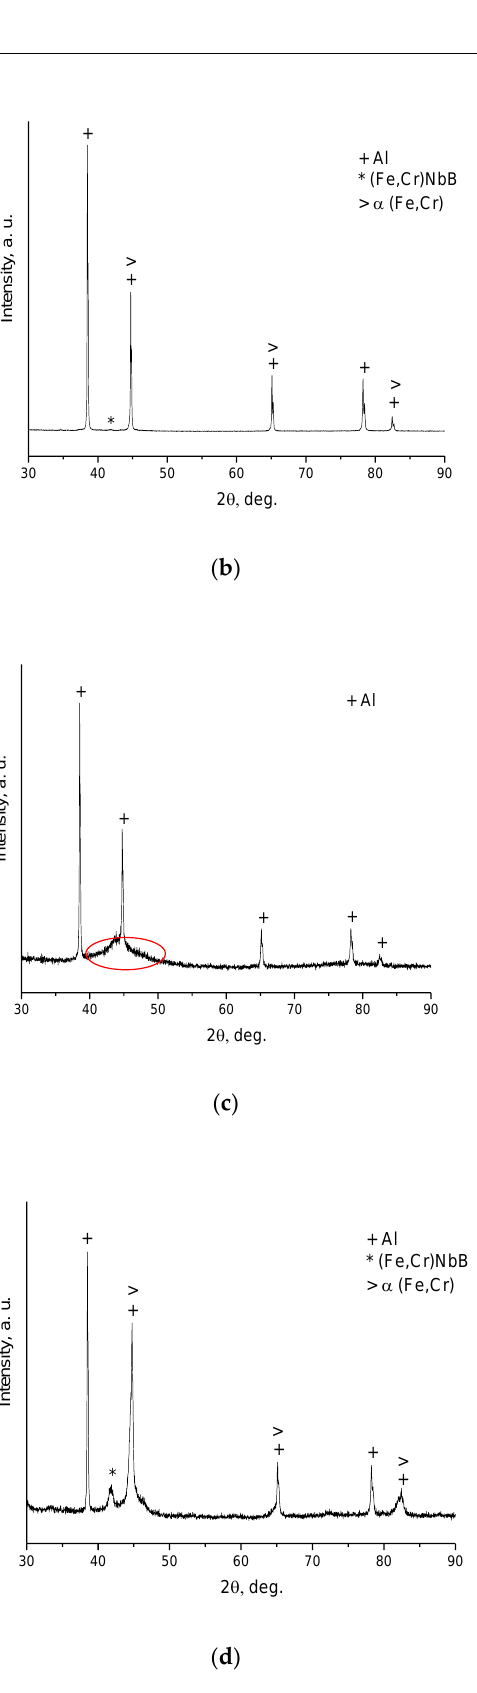
Figure 4. XRD patterns of the spark plasma sintered composites obtained from ( a ) Al (coarse)–glassy Fe 66 Cr 10 Nb 5 B 19 ; ( b ) Al (coarse)–crystalline Fe 62 Cr 10 Nb 12 B 16 ; ( c ) Al (fine)–glassy Fe 66 Cr 10 Nb 5 B 19 ; and ( d ) Al (fine)–crystalline Fe 62 Cr 10 Nb 12 B 16 mixtures. A red oval in ( a , c ) marks the range, in which a diffraction halo is